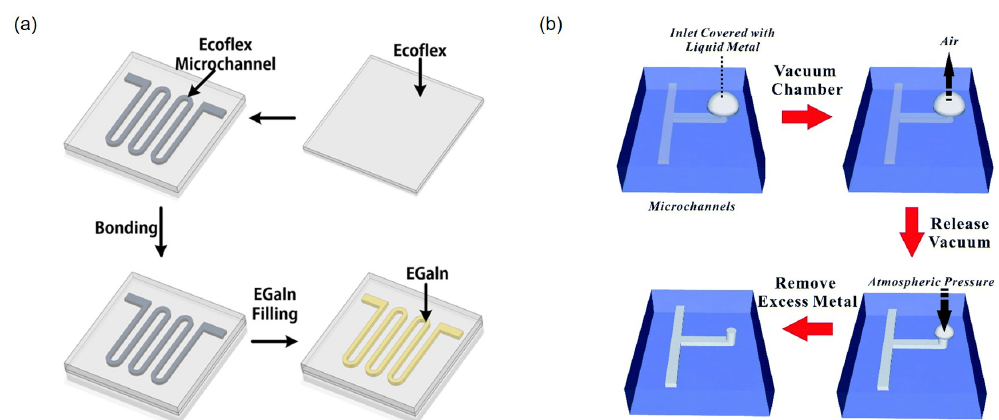
Figure 8. ( a ) Schematic of fabrication process for microchannels made by soft lithography. Injection of a liquid metal in the microchannel makes a liquid metal pattern. Reprinted by permission from Springer Nature: [66], Copyright 2019. ( b ) Schematic showing the sequential process of vacuum filling liquid metal into a T-shaped microfluidic channel with one inlet but no outlets. A liquid metal droplet is dispensed over the inlet. The whole substrate is placed in a vacuum chamber, which removes the air within the microchannel via the gas permeable elastomer. Releasing the vacuum returns the ambient to atmospheric pressure, which pushes the metal into the microchannel. Reproduced from Ref. [67] with permission from the Royal Society of